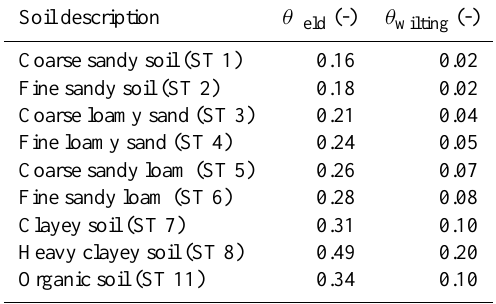
Fig. 2. Mean monthly precipitation in the Vidaa catchment for the current climate, as well as for the future period using both the DC method and the DBS method